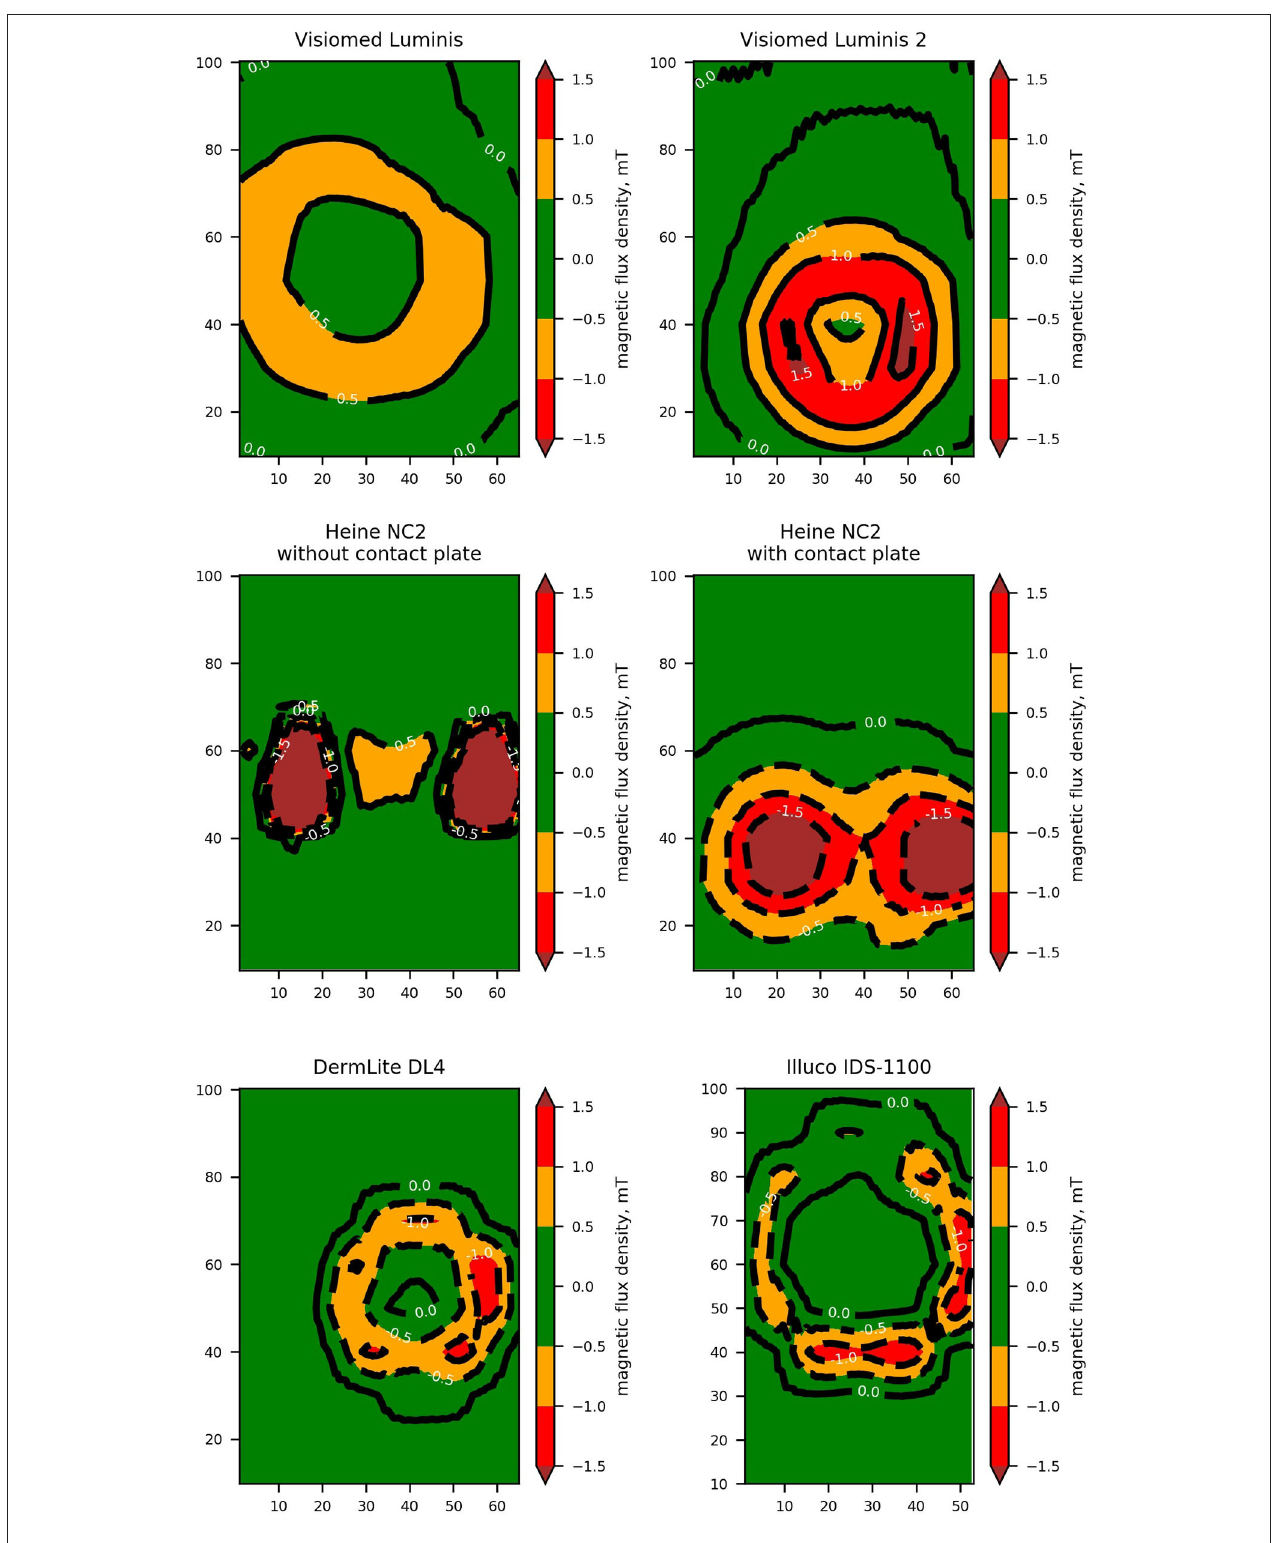
FIGURE 3 | High contrast contour plots representing the perpendicular component of magnetic flux density measured directly over a dermoscope faceplate. Both axes of the contour plots are labeled with a dimension expressed in milimeters. Areas where the magnetic field exceeds thresholds of 0.5, 1.0, and 1.5 mT are